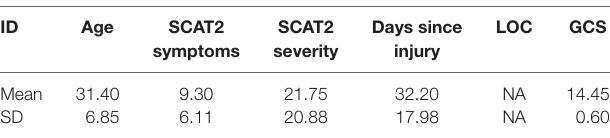
Table 1 | Outcome scores for the concussion group.